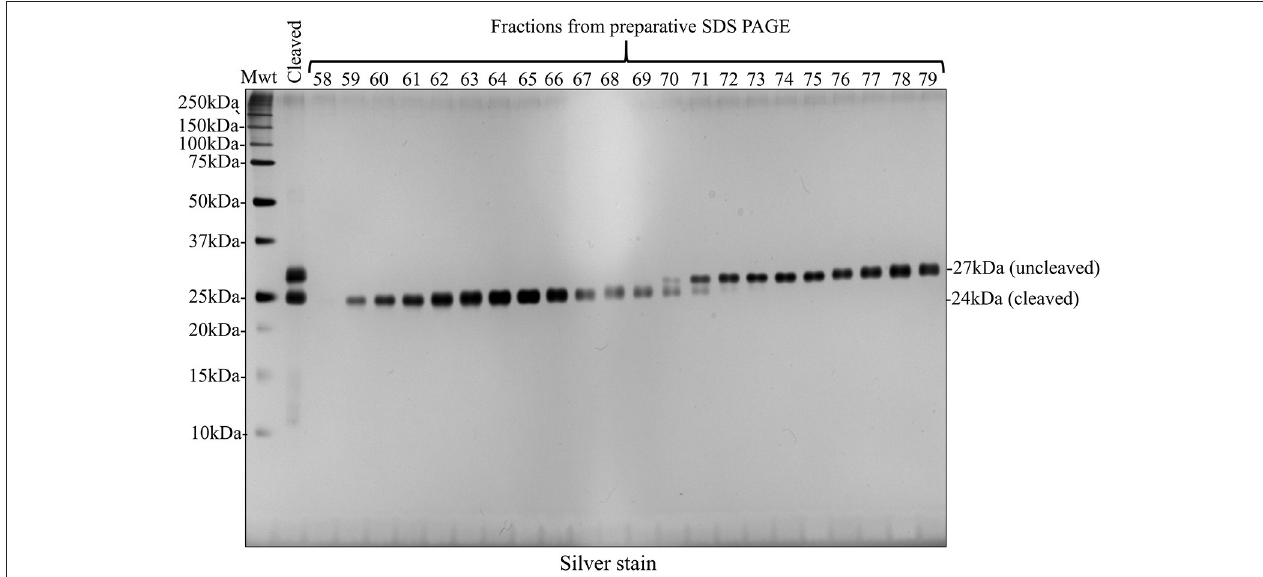
FIGURE 7 | Preparative SDS PAGE purified cleaved recombinant amelogenin to single band purity on silver stained SDS PAGE analytical gels. Fractions 58–79 collected during preparative SDS PAGE of the HRV3C cleavage reaction mixture contained the 24 kDa cleaved and 27 kDa uncleaved recombinant amelogenins. Enhanced resolution of cleaved recombinant amelogenin was achieved compared with nickel column chromatography shown in Figures 5B , 6